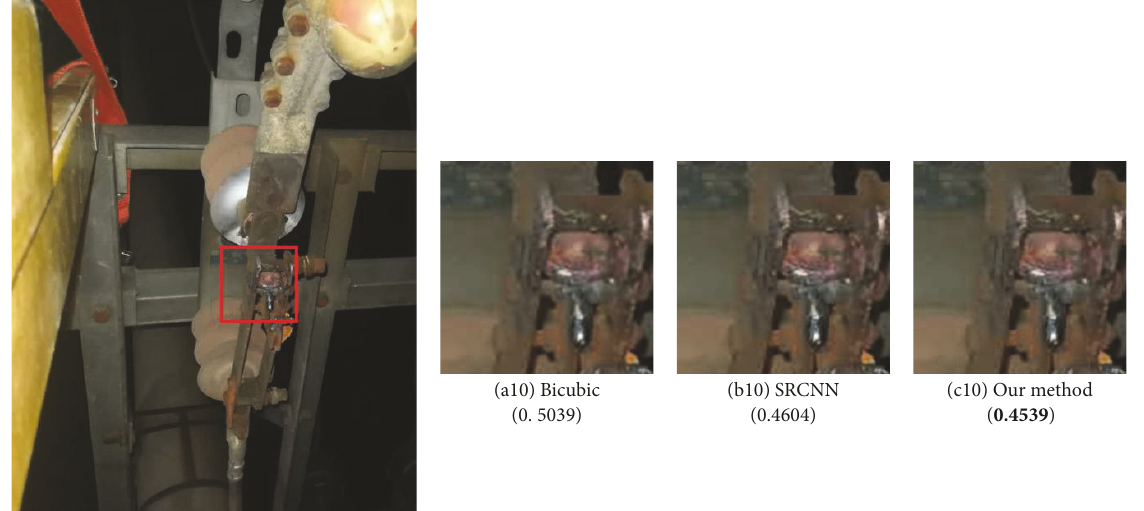
Figure 14: Insulators on poles.